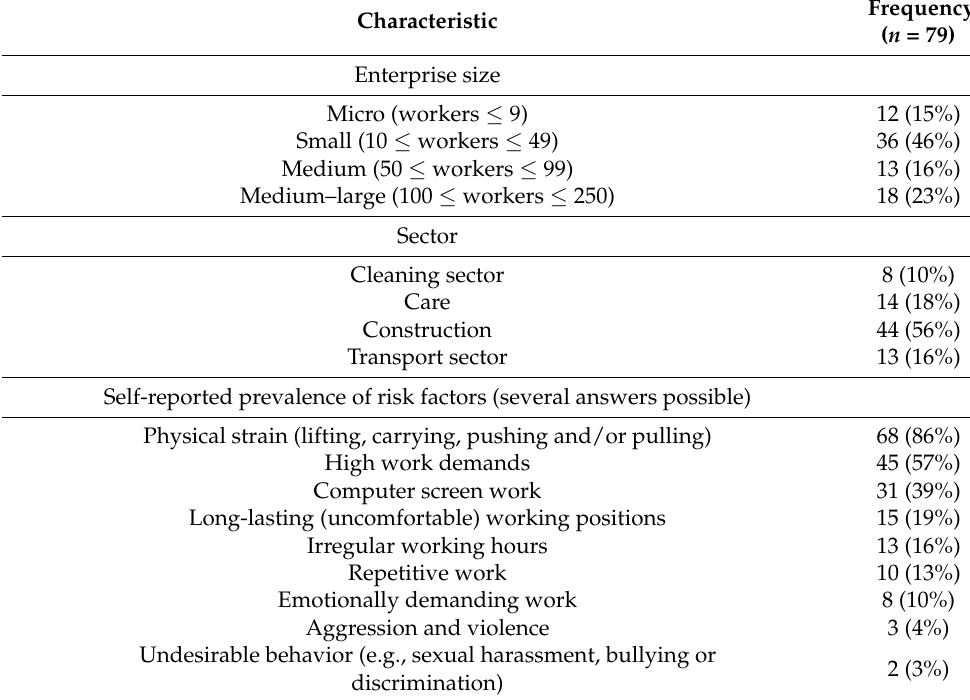
Table 1. Respondent characteristics.